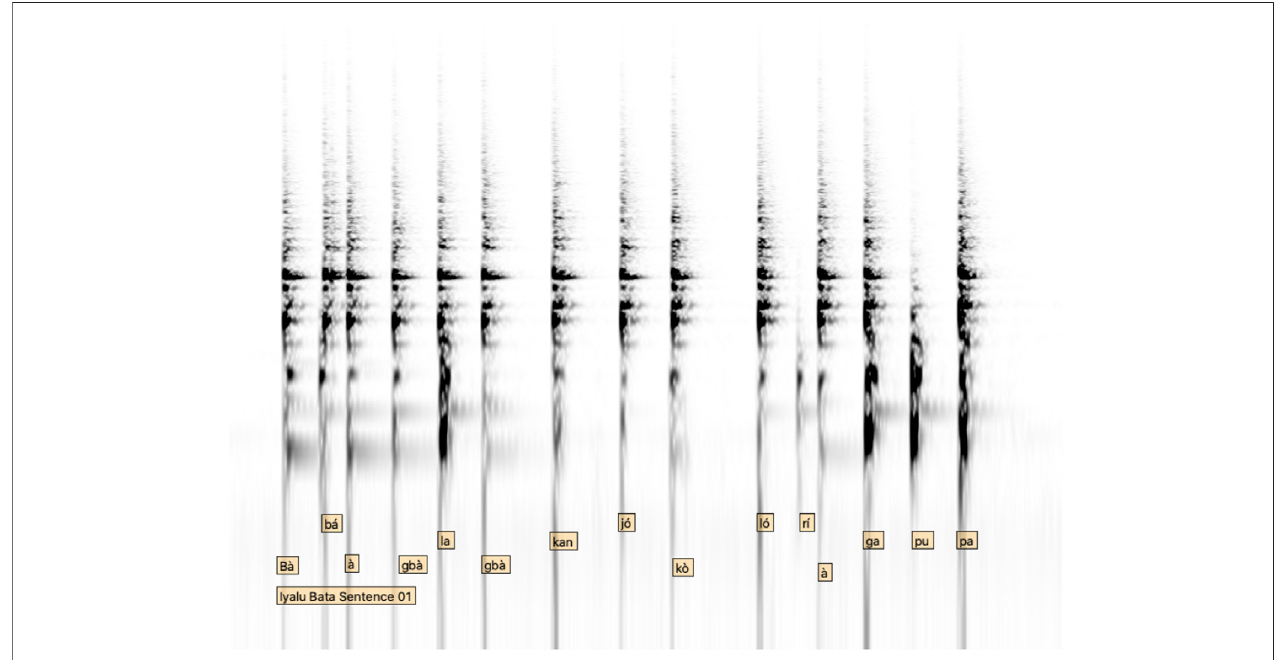
FIGURE 6 | Ìyáàlù bàtá spectrogram for the sentence “ Bàbá àgbàlagbà kaán jókòó lórí àga pupa ” ( “ there is an old man sitting on a red chair ” ).